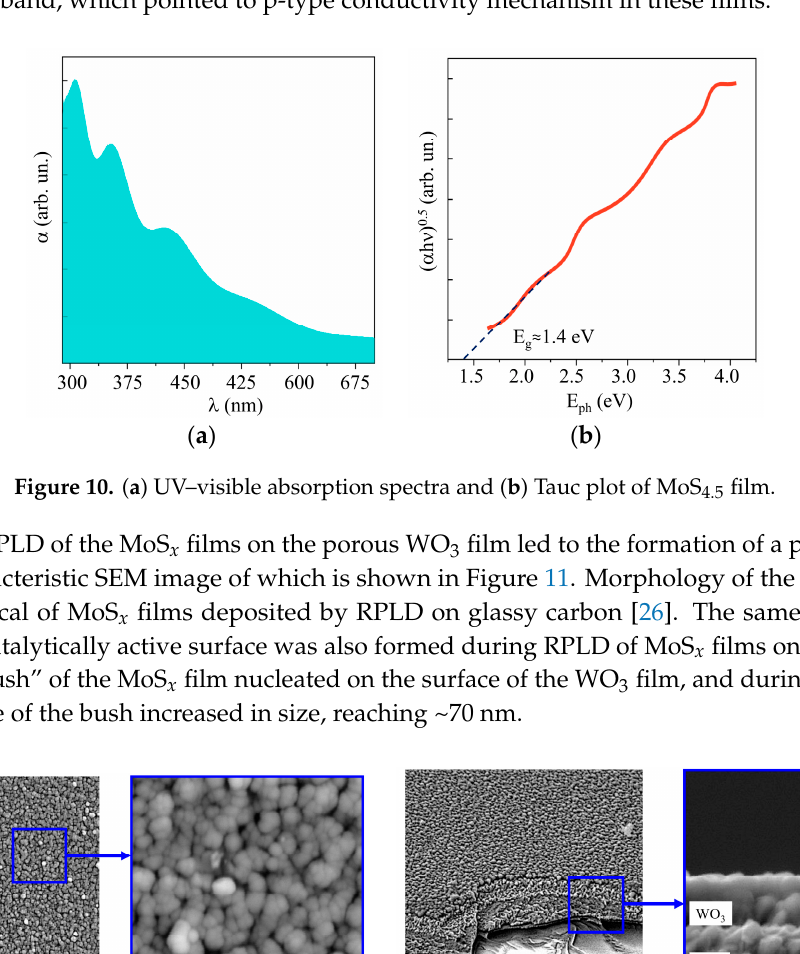
Figure 11. The ( a ) planar and ( b ) cross-section SEM images of the MoS 4.5 /WO 3 /FTO sample.